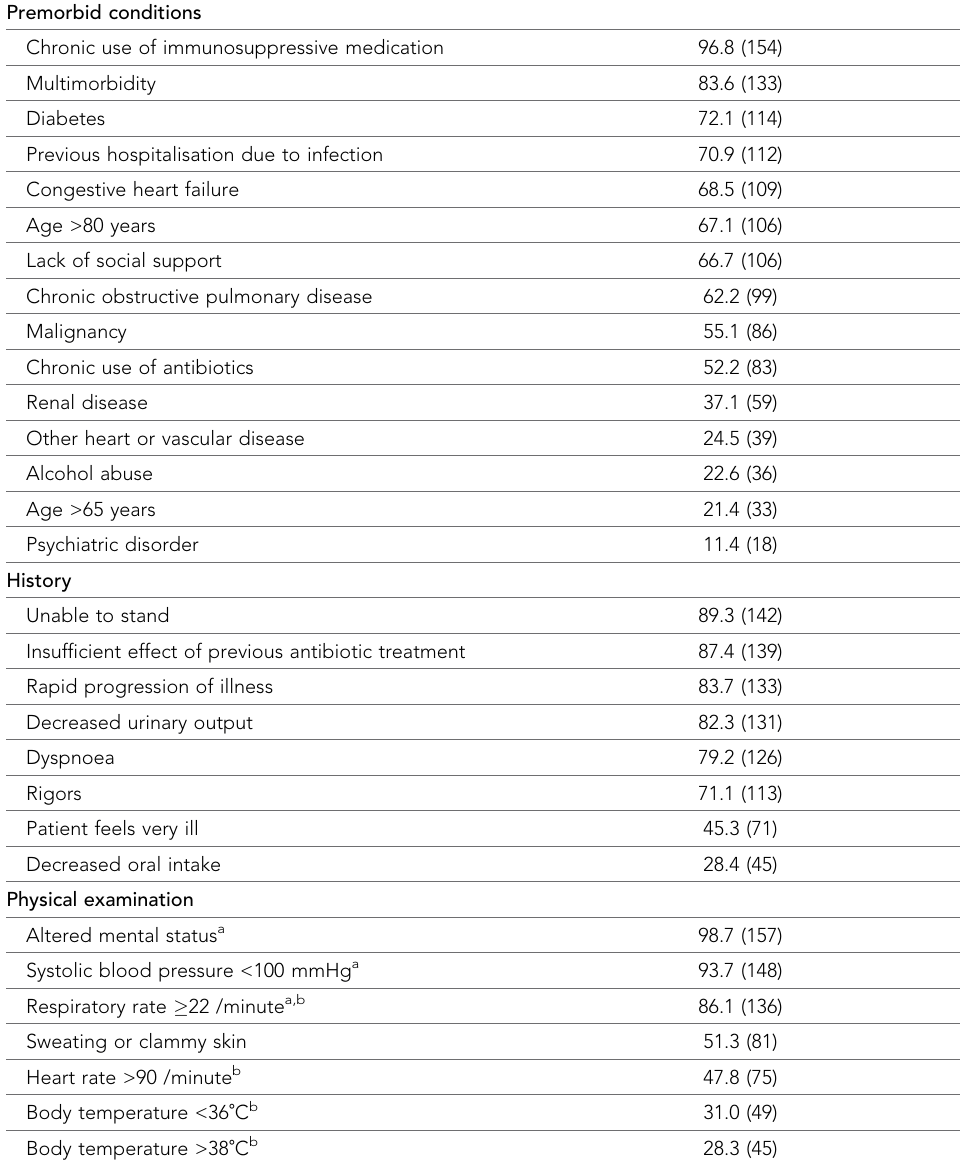
Table 4. Importance of premorbid conditions and aspects of the history and physical examination for the decision to refer a patient with a possible serious